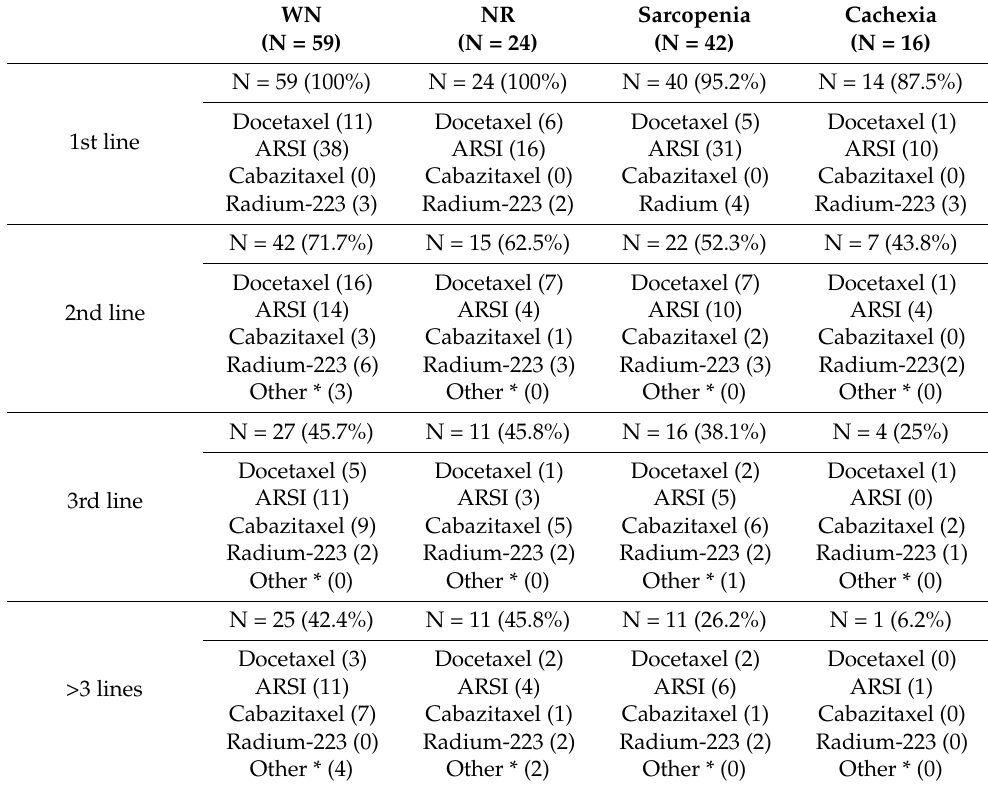
Table 1. Systemic treatment according to the line and type of therapy in each nutritional